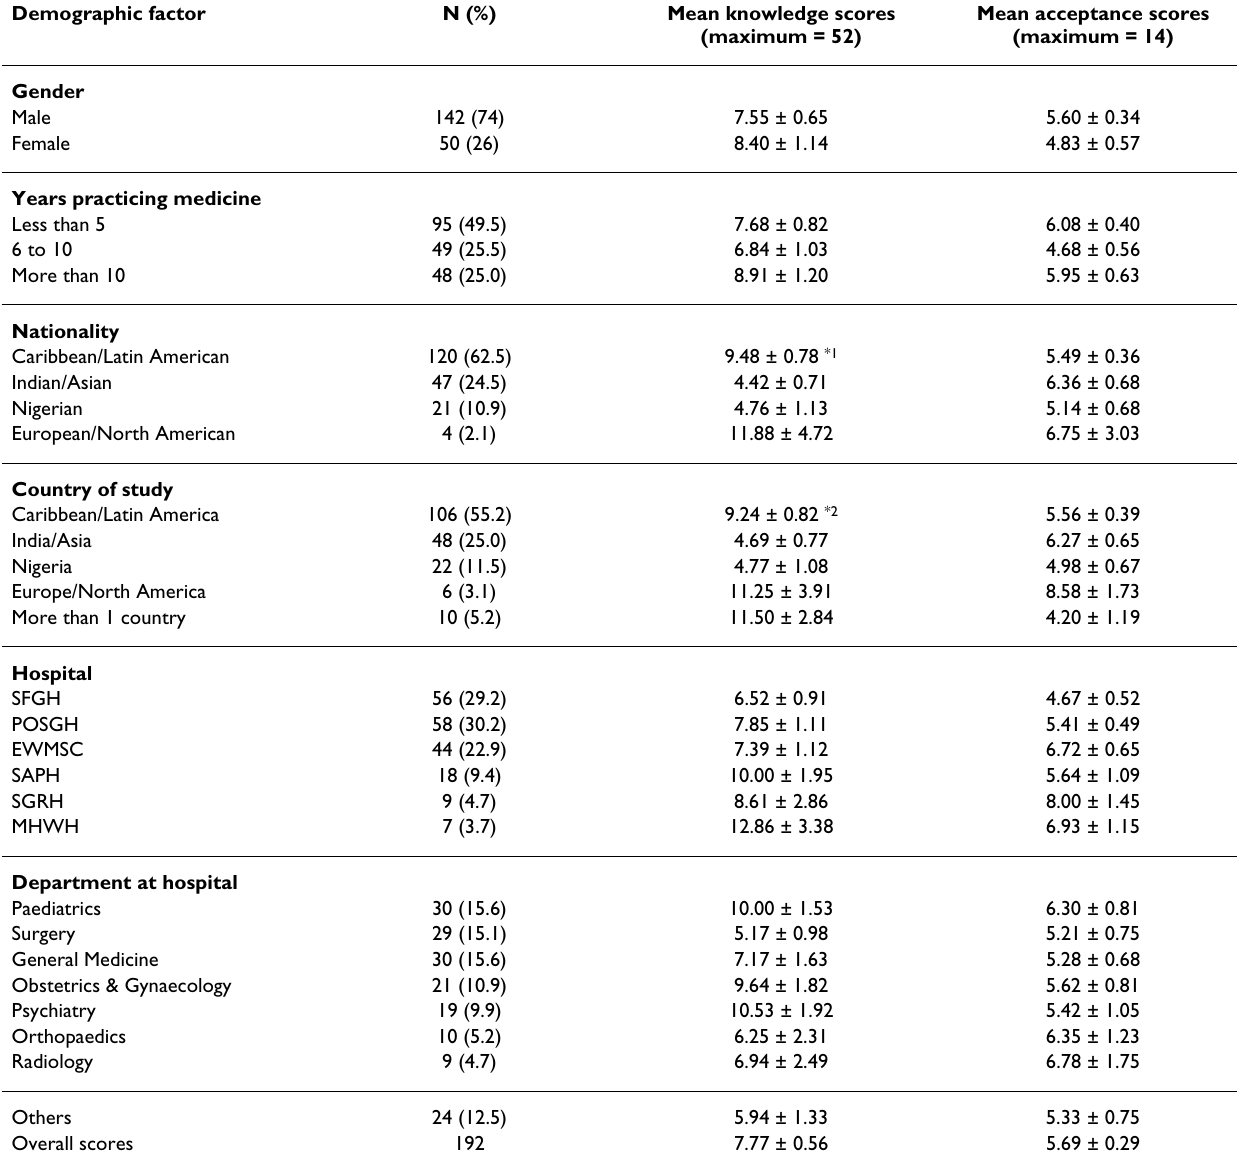
Table 1: Demography and factors affecting knowledge and acceptance of herbal medicines of public health sector physicians in Trinidad Demographic